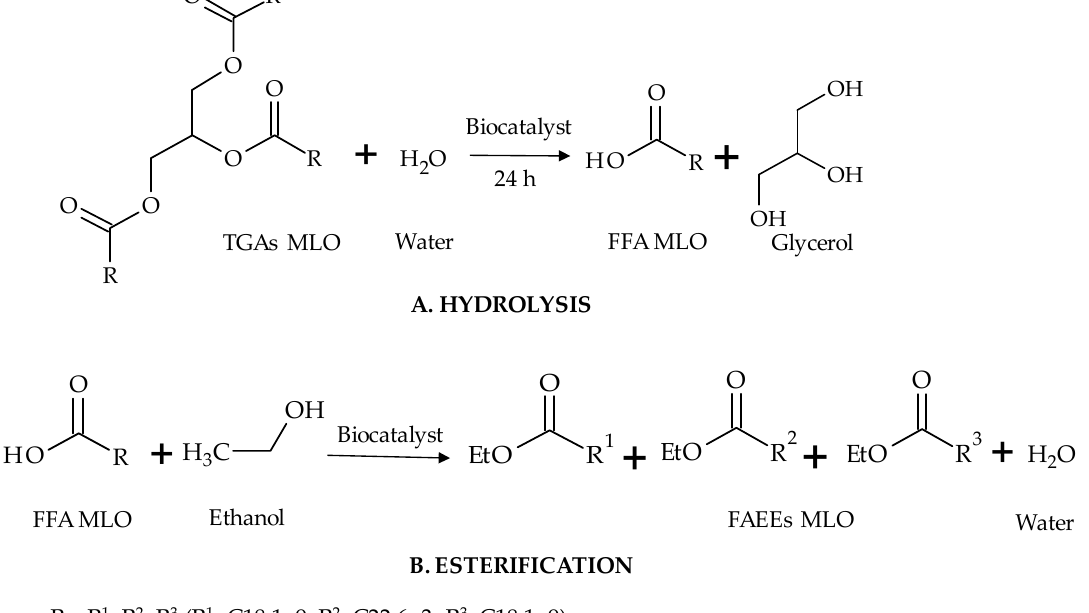
MLOBiocatalyst TGAs MLO Ethanol FAEEs R = R 1 , R 2 , R 3 (R 1 : C18:1n9, R 2 : C22:6n3, R 3 : C18:1n9) Catalysts 2021 , 11 , x FOR PEER REVIEW Figure 2. Schematic reaction diagram of the synthesis of ethyl esters in the one-step transesterification reaction.